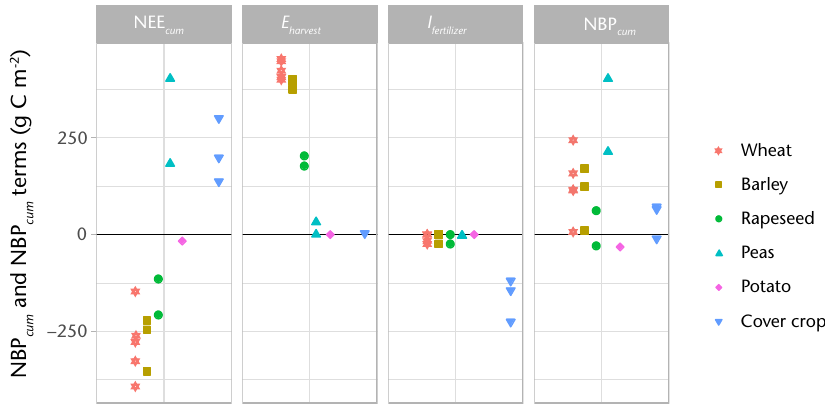
Figure 4. Crop-season-specific cumulative net biome production (NBP cum ) and the main contributing terms: cumulative net ecosystem exchange (NEE cum ), C export by harvest ( E harvest ) and C import by fertiliser ( I fertiliser ). Each symbol stands for one crop season. Not shown is the C import by sowing ( I sowing ), which is negligibly small except for potatoes. It is, however, included in the calculation of NBP cum . Please note that cover crops were only grown during autumn and